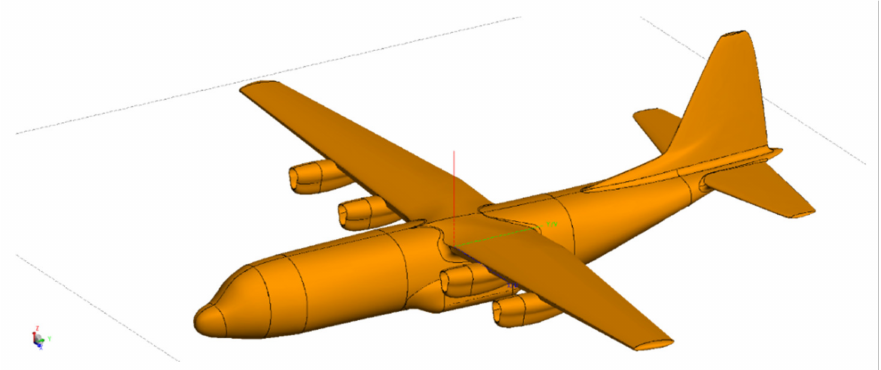
Figure 2. Typical transport aircraft electromagnetic